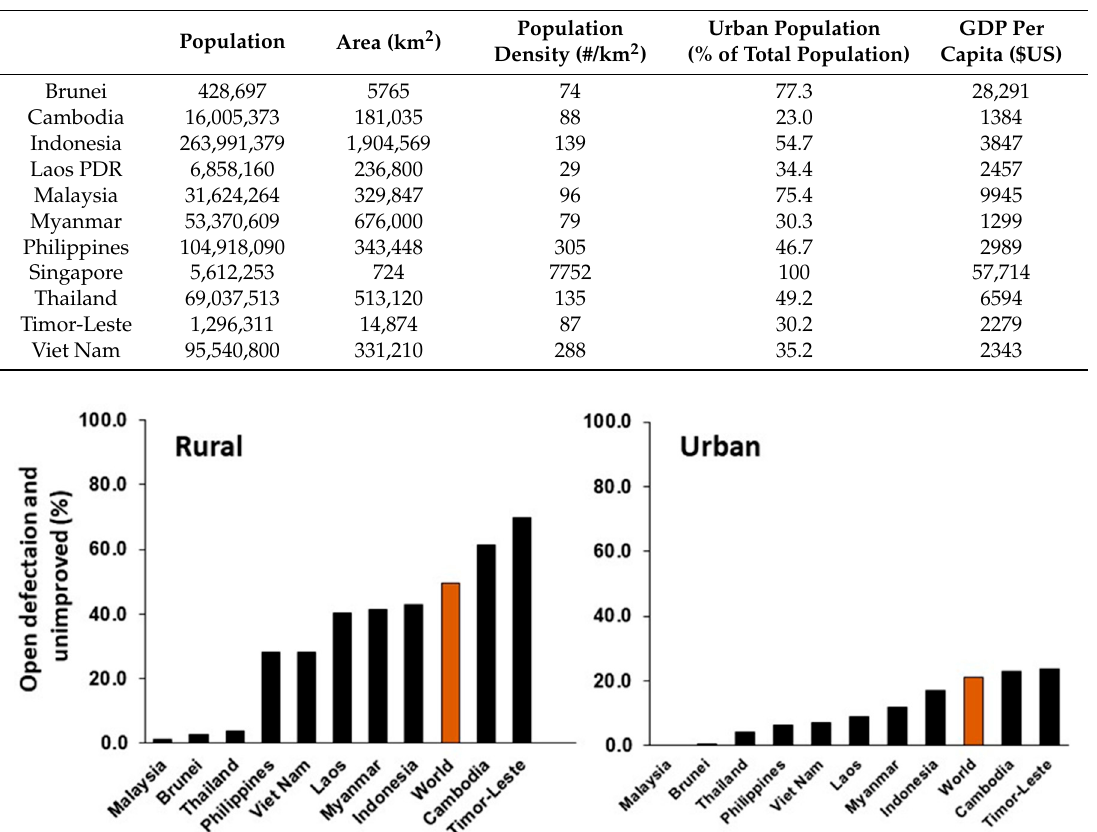
Figure 5. Percentages in 2017 of rural and urban populations [16] in the case study countries who practice open defection or have unimproved basic sanitation; i.e., a limited barrier between one person’s faecal matter and the next [12]. The mean level for the world is shown in brown.